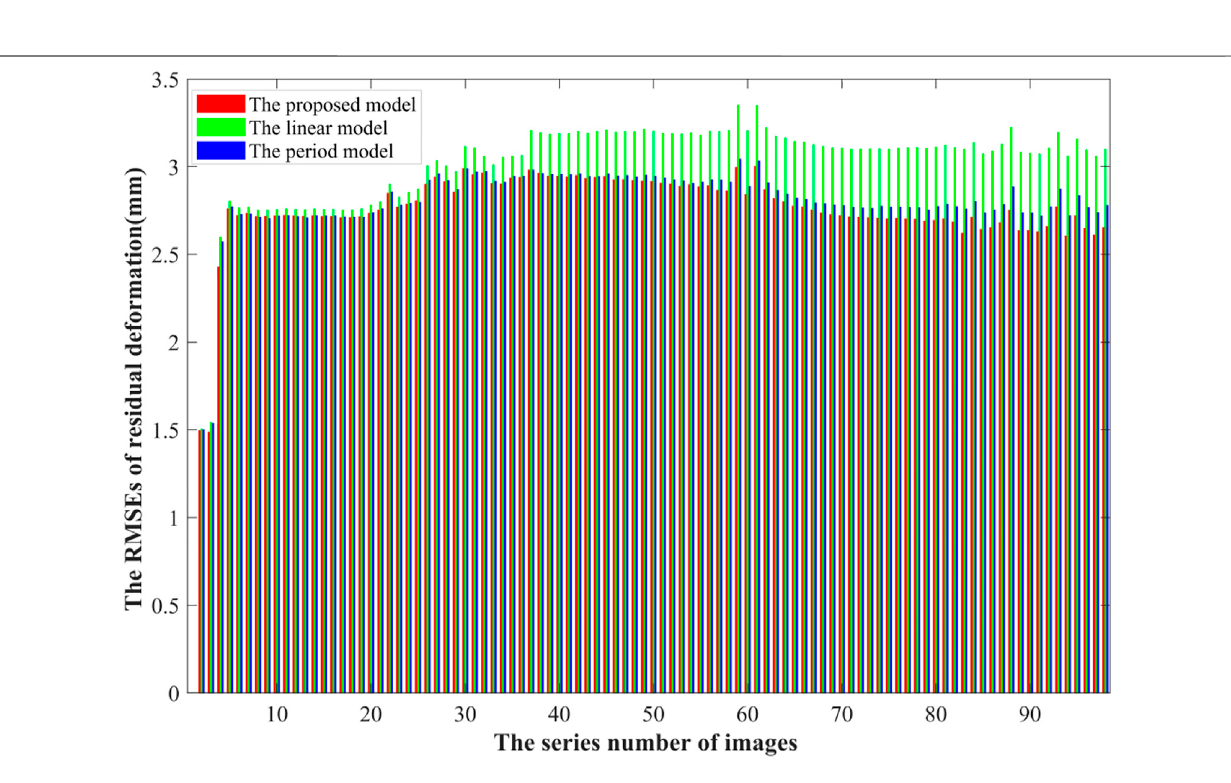
Frontiers in Environmental Science | www.frontiersin.org July 2022 | Volume 10 | Article 953442